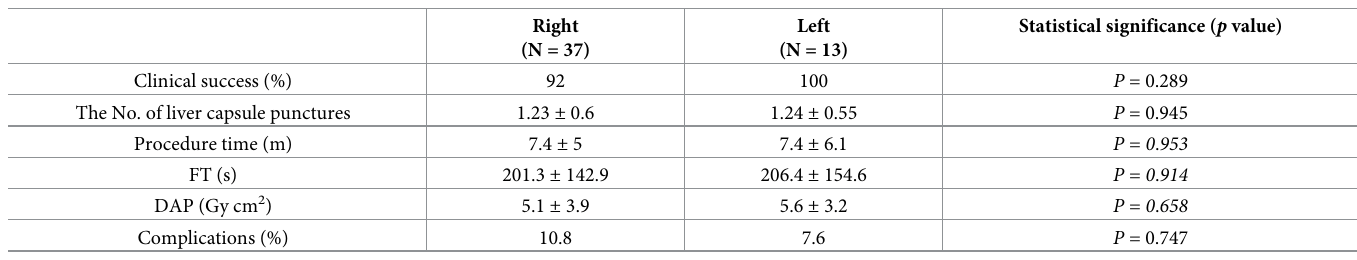
Table 4. Procedural data reported for right-sided and left-sided